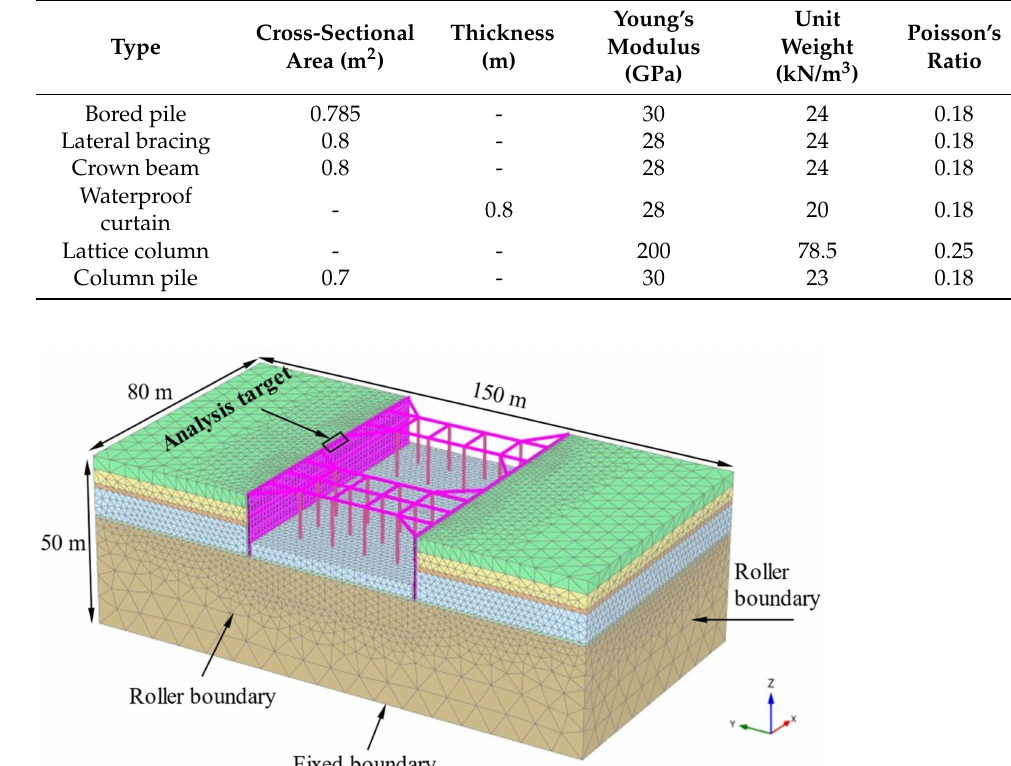
Table 1. Physical and mechanical parameters of retaining structures.